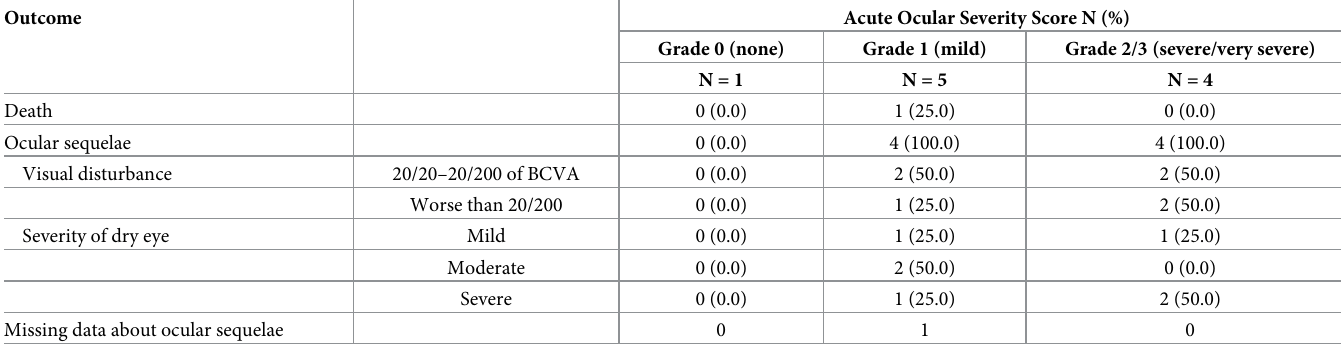
Table 5. Outcomes and ocular sequelae of the patients in whom the period of elapsed time from disease onset to the initial ophthalmological examination was more than 30 days.